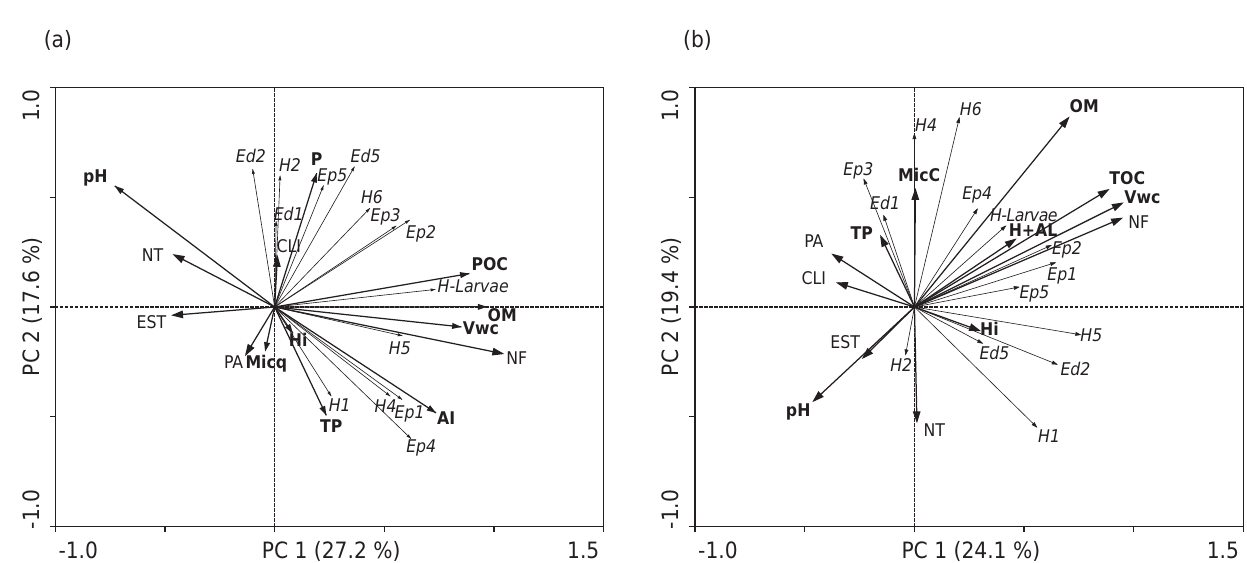
Figure 2. Principal component analysis of Coleoptera morphotypes (italic letters) distinguishing land use systems in winter (a), summer (b), and environmental variables (bold), used as explanatory variables, on the Southern Santa Catarina Plateau. NF: native forest; EST: Eucalyptus stands; PA: perennial pasture; CLI: crop-livestock integration; NT: no-tillage; Ed: edaphic; H: hemi-edaphic; Ep: epigean; H+Al: potential acidity; OM: organic matter; TOC: total organic carbon; POC: particulate organic carbon; MicC: microbial biomass carbon; Micq: microbial quotient; Vwc: soil volumetric water content; TP: total porosity; P: phosphorus; Hi: hydrogen; Al: